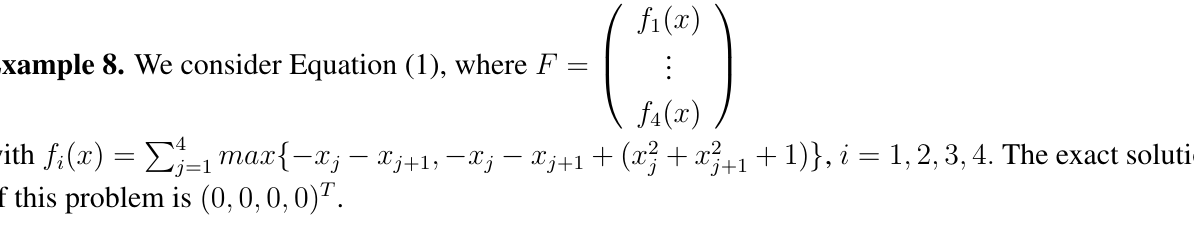
Table 8. Number of iterations and the final value of Ψ( x ∗ )